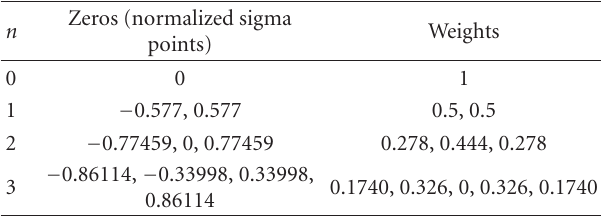
Figure 5: CDF to bandwidth. Table 1: Sigma points and weights for the normalized uniform distribution.